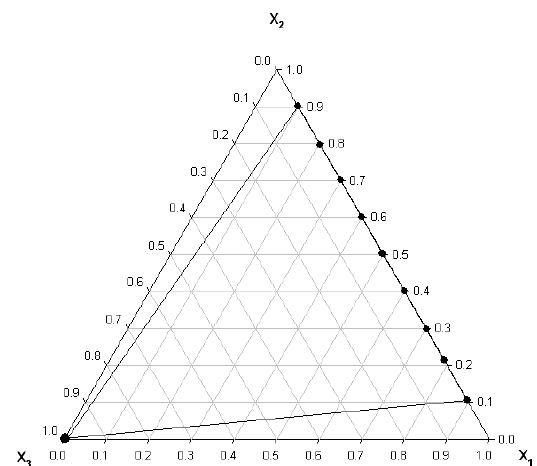
Figure 1. Ternary graph for the system: benzyl alcohol (1) — n-hexanol (2) — water (3). The viscosity values experimentally measured at different temperatures for pure com- pounds are presented in Table 1, and those for binary and ternary mixtures are presented in Table